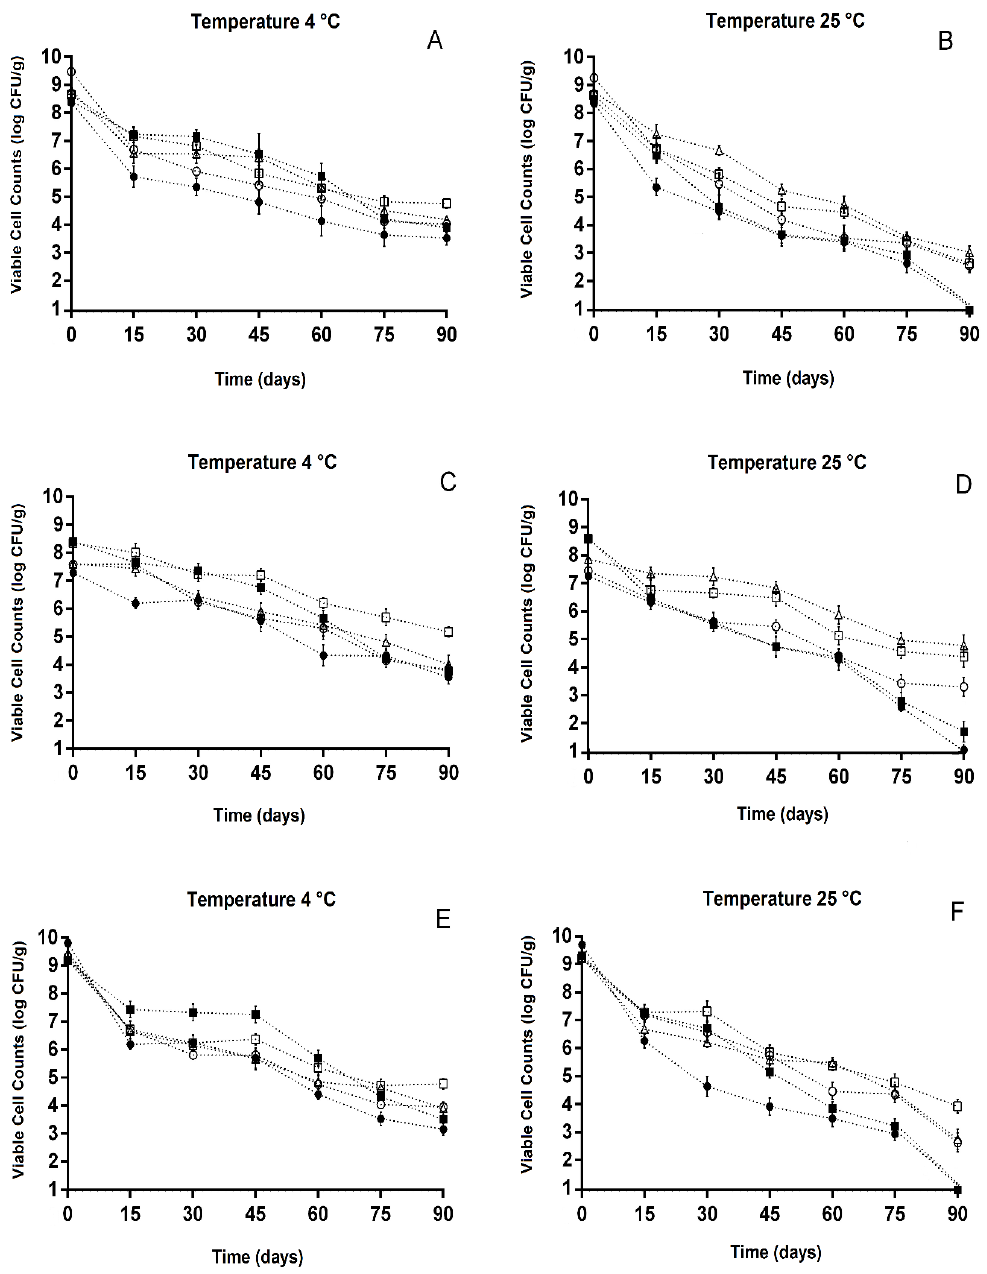
Figure 4. Viable cell counts (log CFU / g) of ( A ) L. paracasei L-10, ( B ) L. casei L-26, and ( C ) L. acidophilus LA-05 freeze- dried in the absence (NEC, ●) or presence of fructo-oligosaccharides (FOS, ■ ) or processing coproducts of acerola (ACE, □ ), cashew (CAS, ▵ ), or guava (GUA, ○ ) during 90 days of storage at 4 ± 0.5 °C ( A , C , E ) or 25 ± 0.5 °C ( B , D , F ).